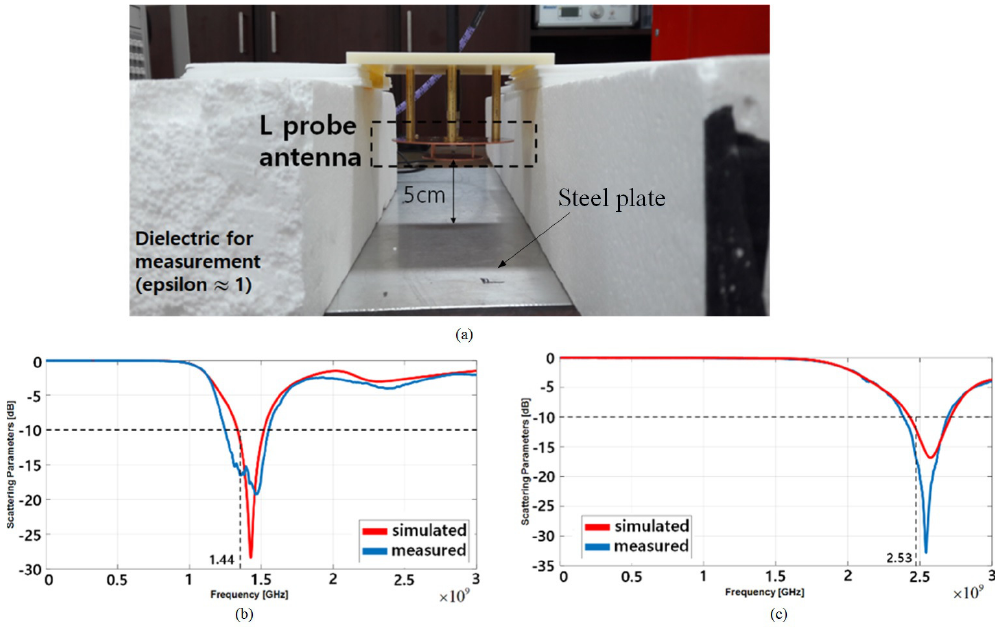
Figure 8. Comparison of the measured and simulated S -parameters: ( a ) Experiment setup for the S -parameters measurements; ( b ) S -parameters of L-probe antenna for 1.2–1.4 GHz (1st E-probe); and ( c ) S -parameters of L-probe antenna for 2.7–3.1GHz (2nd E-probe).